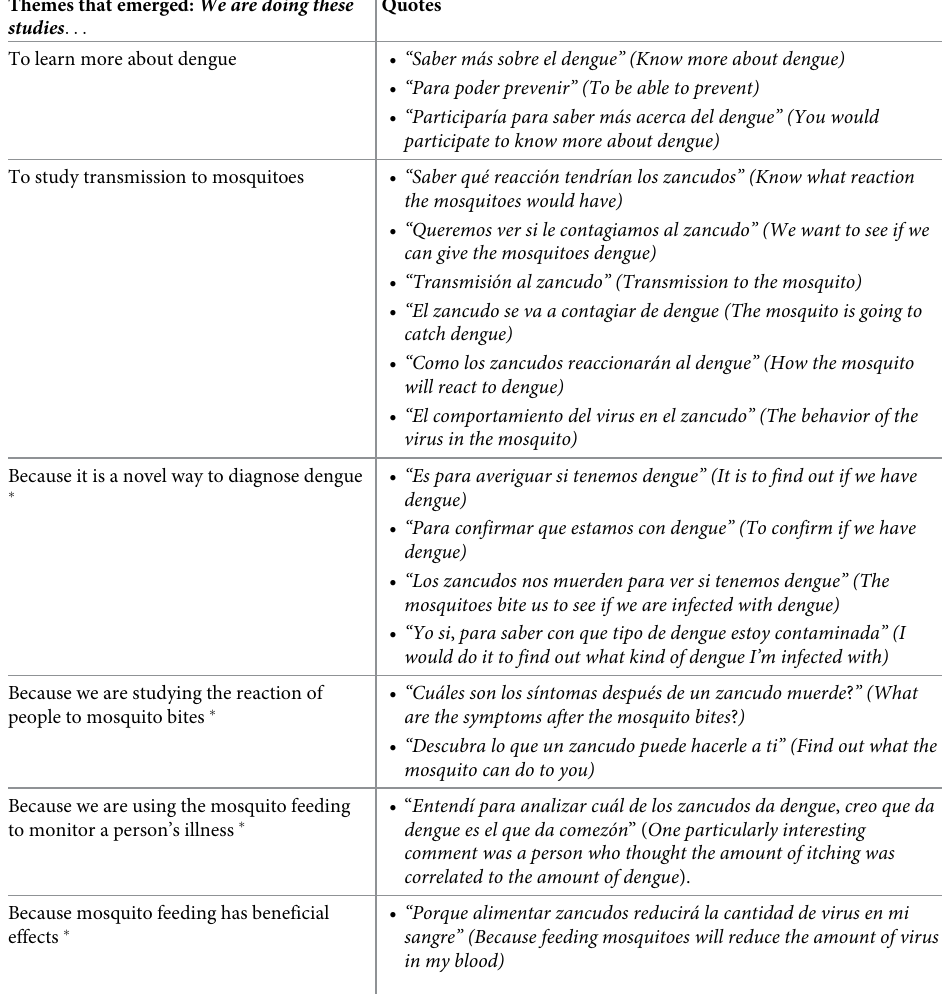
Table 3. Assessment of comprehension of participants in 11 focus group discussions about the reason the mos- quito feeding studies are being carried out and to verify that the objectives stated in the video were clear. Themes that emerged: We are doing these studies